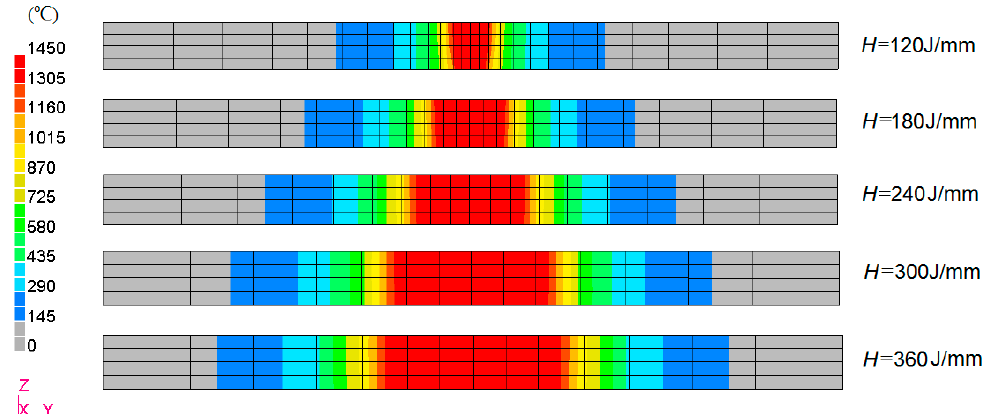
Figure 14. Weld penetration under various heat input condition.